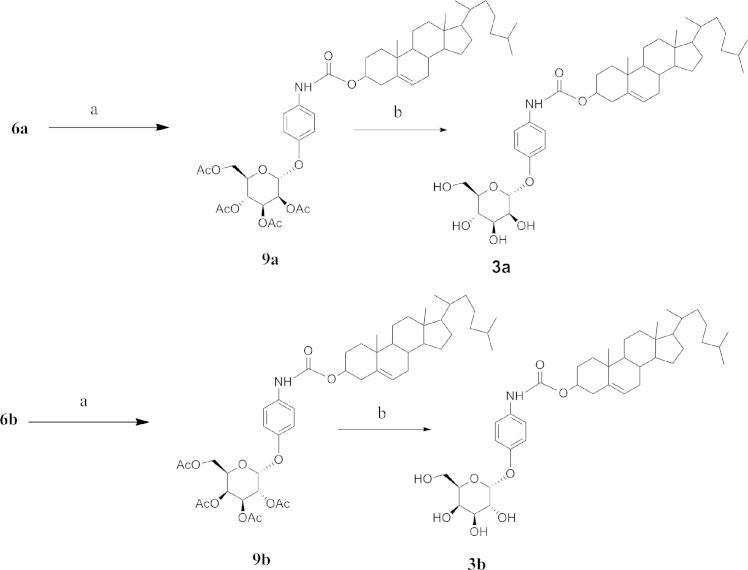
Reagents: (a) Cholesterol Chloroformate, Et3N, CH2Cl2, (b) NaOMe/MeOH.